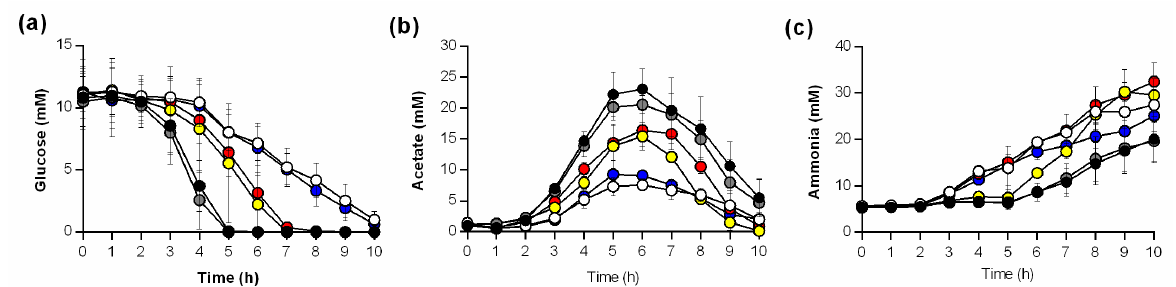
Figure 2. Impact of ptsH and/or ccpA on glucose consumption, acetate and ammonia production of S. aureus Newman during in vitro growth. S. aureus strains Newman (black symbols), Nm ptsH (white symbols), Nm ptsH::ptsH (grey symbols), Nm ptsH * (yellow symbols), Nm ccpA (red symbols), and Nm ccpA_ptsH (blue symbols) were cultivated in TSB, and glucose ( a ), acetate ( b ), and ammonia ( c ) concentrations in culture supernatants were determined hourly. Results are presented as the average and standard deviation of at least three independent experiments.